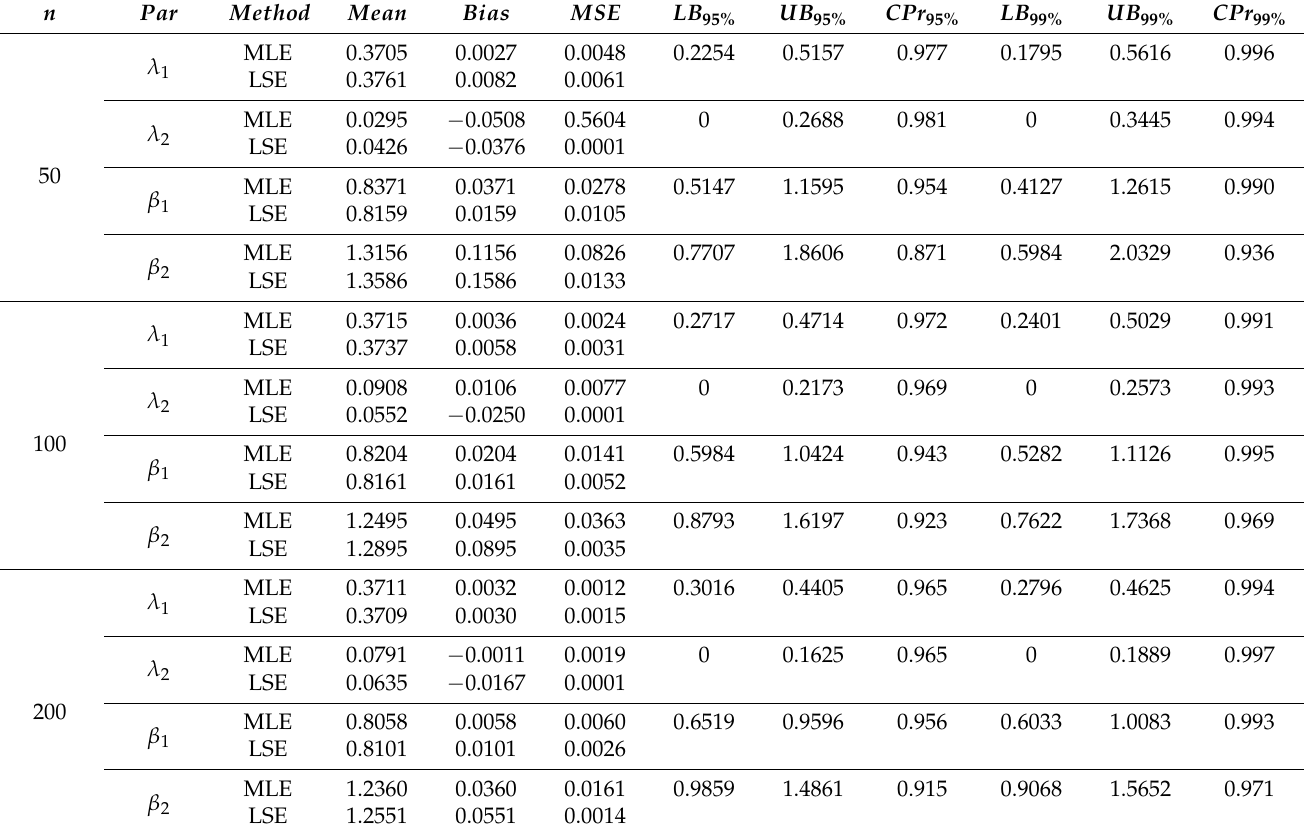
Table 4. The results of MLEs, LSEs, interval estimates, and CPrs when β 1 = 0.8, β 2 = 1.2, λ 1 =